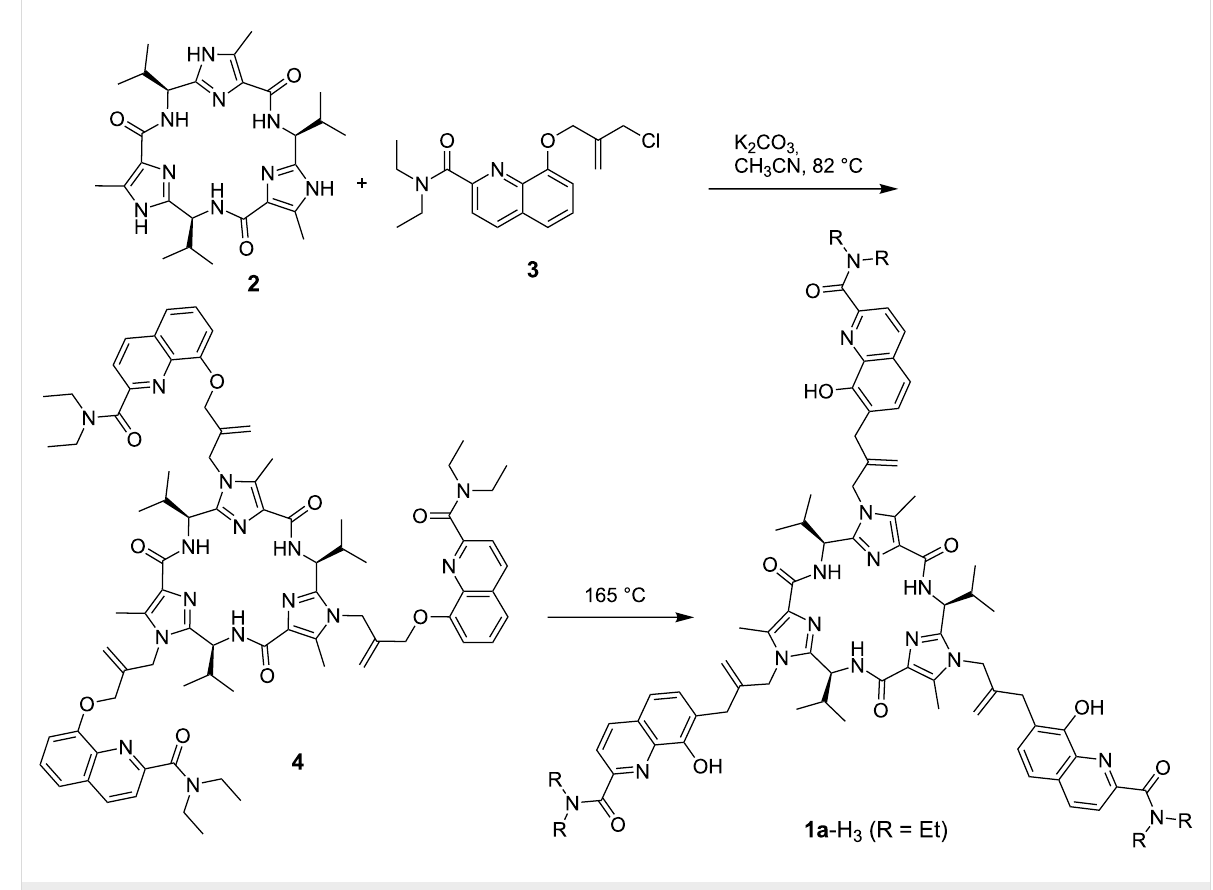
Scheme 1: Preparation of the compound 1a -H 3 by utilization of a multiple Claisen-rearrangement.